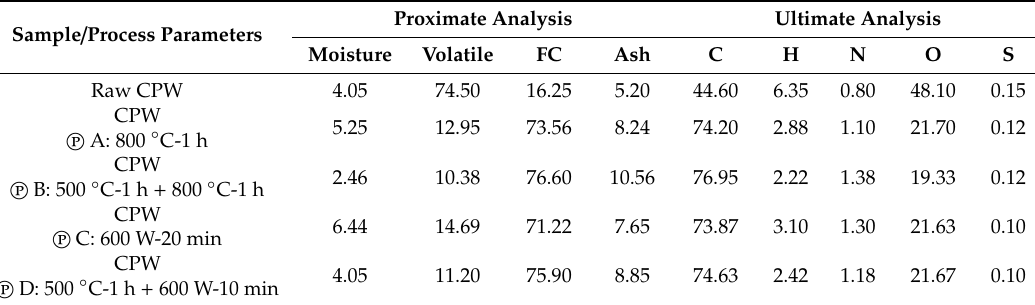
Elemental analysis of combine palm waste activated carbon based on di ff erent production